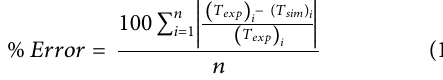
Frontiers in Materials |